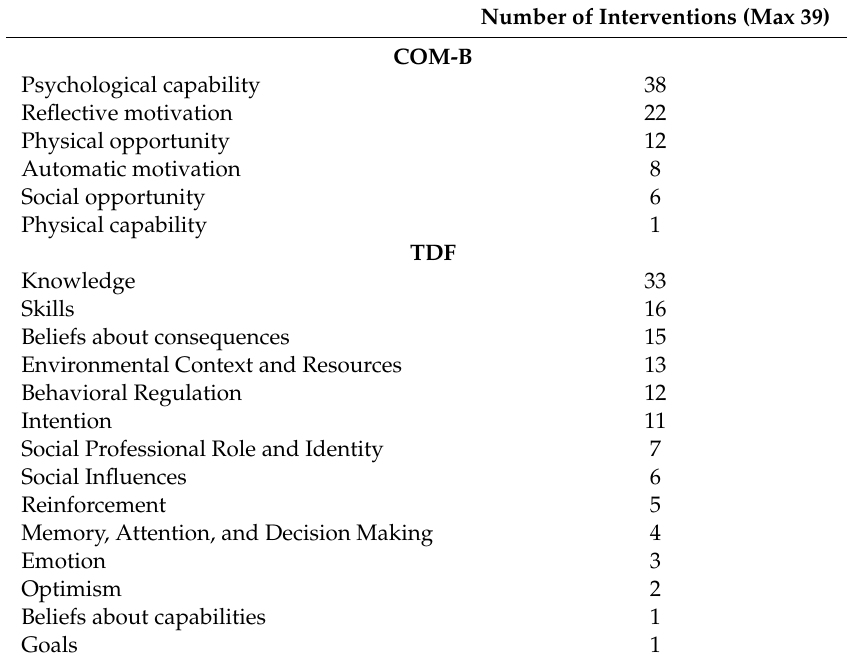
Table 6. Frequency of interventions targeting influences on behavior.